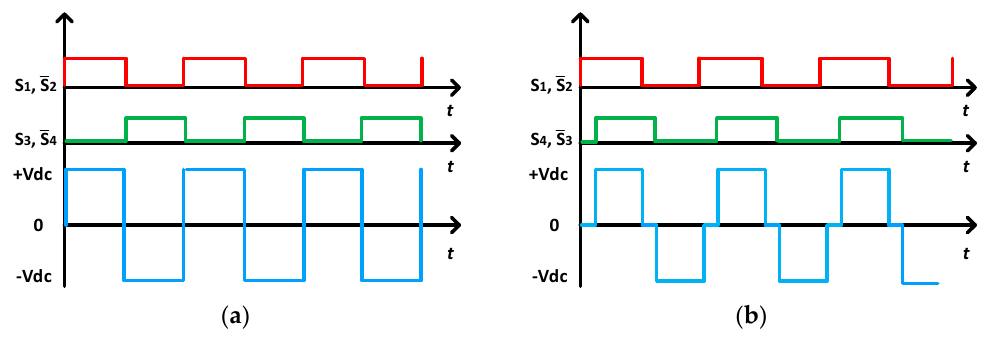
Figure 4. Modulation signals: ( a ) 2L, ( b ) 3L.